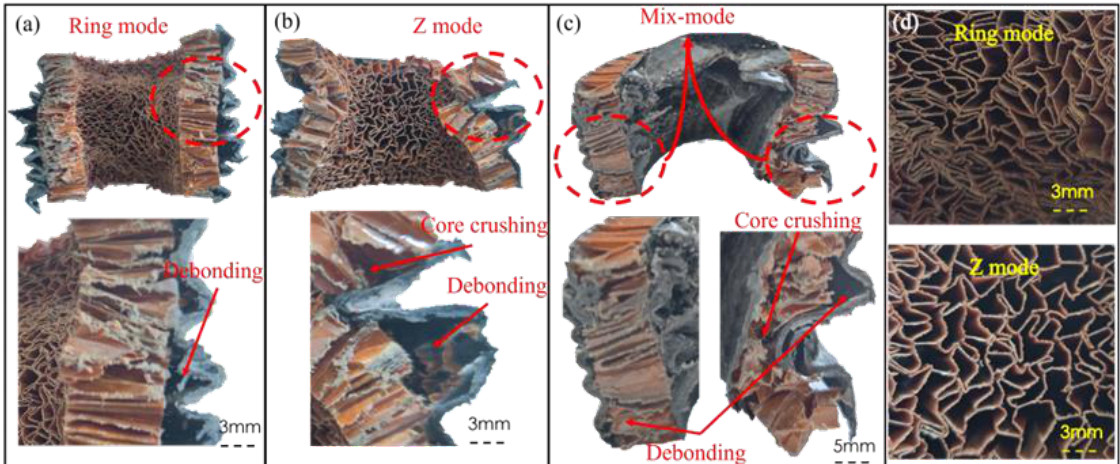
Figure 14. Three failure modes of the thin AHST tube after axial compression. ( a ) the ring mode, ( b ) the Z mode and ( c ) the Mix mode. ( d ) Detail diagram of the failure modes.